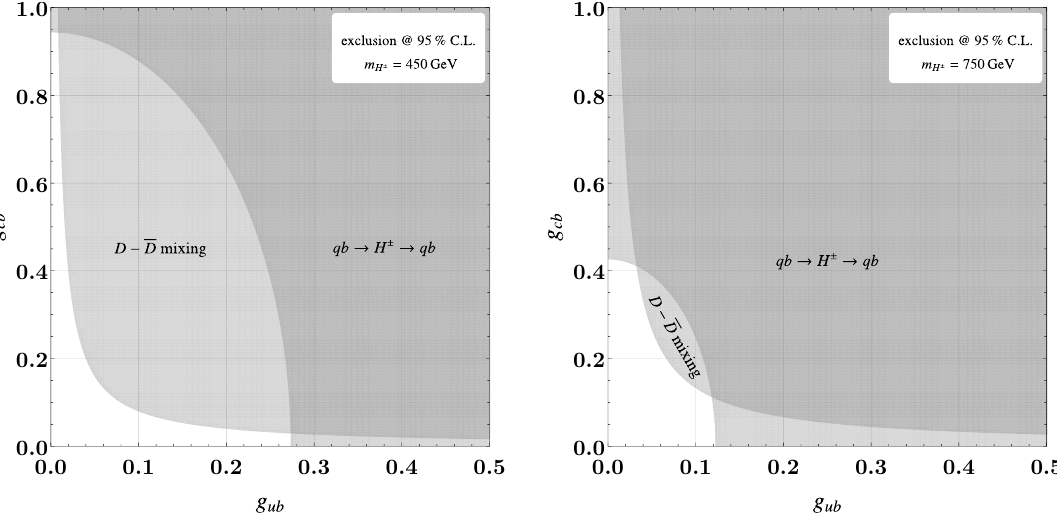
= 450 GeV (left panel) H ±